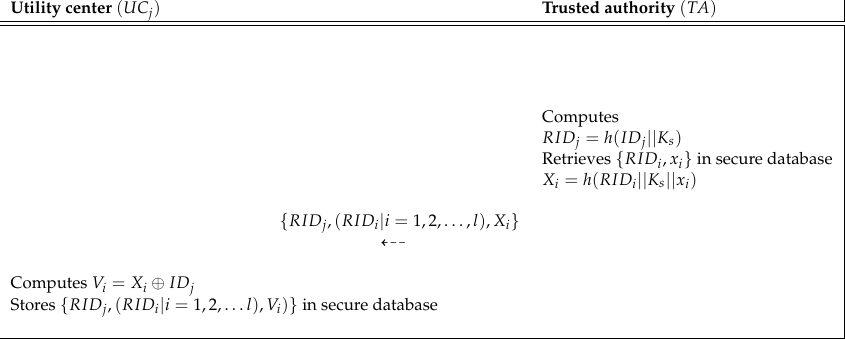
Figure 7. Utility center registration process of the proposed